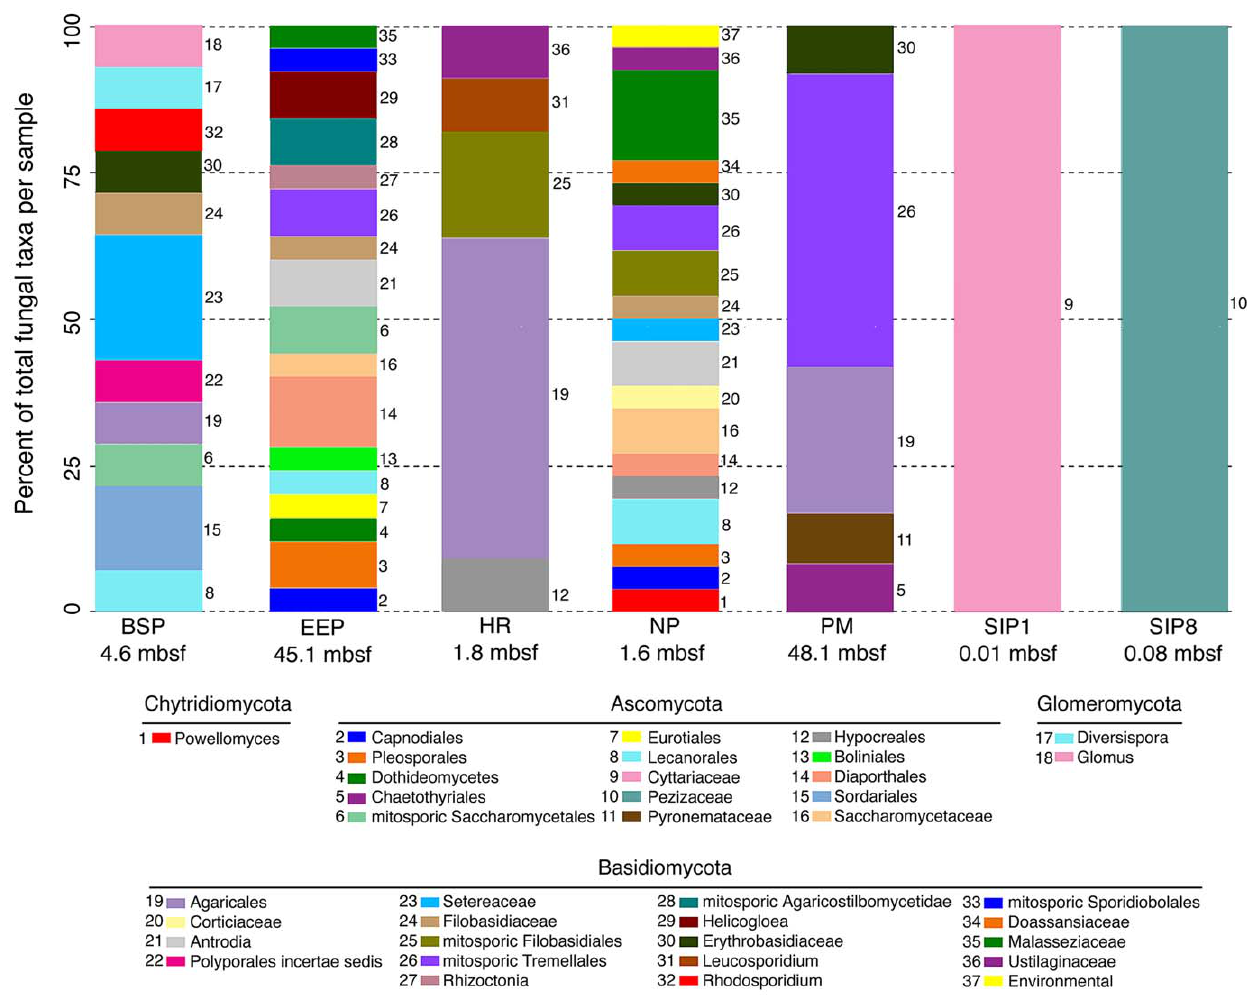
Figure 4. Taxonomic affiliation of fungal OTUs sharing 97% sequence identity from subseafloor and shallow sediment samples. Bar sizes are proportional to taxonomic richness. See Table 1 for sample information. Figure S3 Abundance of fungal T-RFs within the different samples (A) and the overlap in fungal T-RF ’ s between subsurface and shallow sediments (B). See Table 1 for sample information.